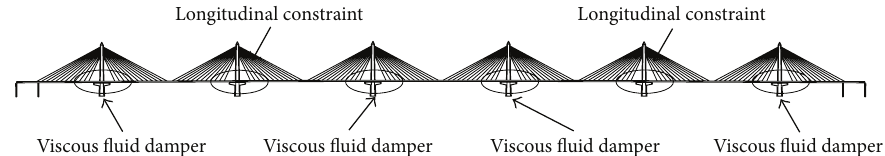
Figure 6: Installation of viscous fluid dampers in the bridge.